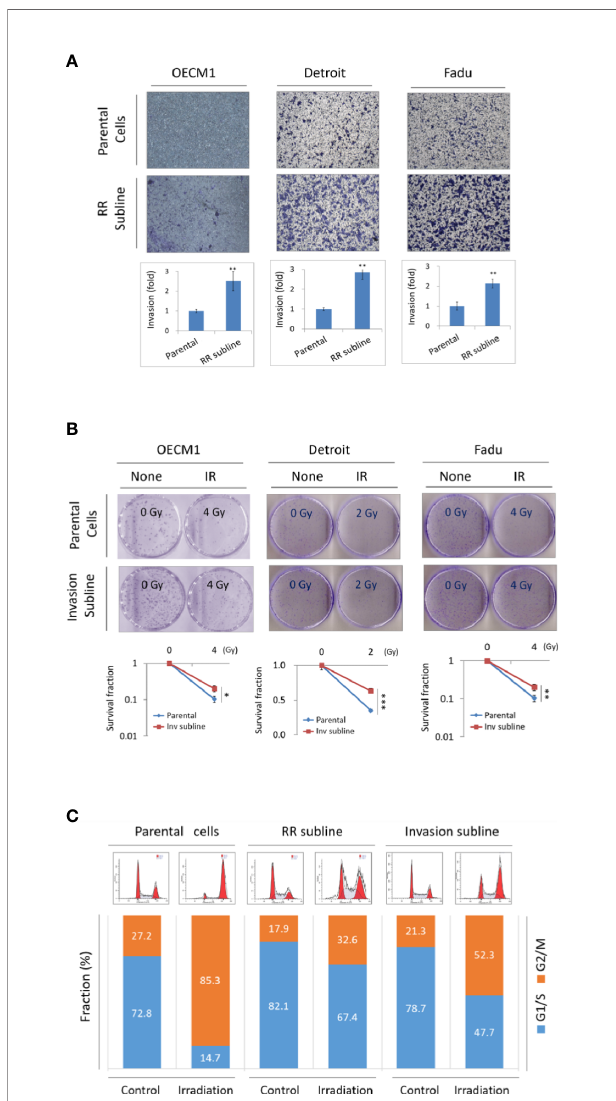
FIGURE 1 | Phenotypic cross-talk between cell invasion and radioresistance in HNC. (A) Radioresistant sublines exhibited higher cell invasion ability compared to the parental cells, as determined by Matrigel invasion assay. Total of 3 HNC parental cell lines (OECM1, Detroit, and Fadu) and their radioresistance sublines (RR sublines) were examined. The numbers of cells that had invaded through the Matrigel to the reverse side were stained, photographed and quanti fi ed. (B) The invasion sublines showed statistically more resistant to irradiation compared to their parental cells, as determined by clonogenic survival assay. Total of 3 HNC parental cell lines (OECM1, Detroit, and Fadu) and their invasion sublines were examined. The colony survival fractions were determined after the cells were irradiated with 2 or 4 Gy. The experiments were performed for three times, and the similar results were obtained. The error bars shown in the relevant fi gures indicated the standard deviation of the three independent experiments. (*p < 0.05, **p < 0.01, ***p < 0.001, t-test). (C) Both Invasion and radioresistant sublines enrich cells at G1/S phase in response to irradiation. The OECM1 parental cell, the RR subline or the invasion subline were examined. Cells were then synchronized to the G0 phase by replacing the culture medium with serum- free medium. The cells were treated with a single dose of 6 Gy of irradiation and continuously cultured for 24 hours. In each sample, cell cycle distribution was determined by fl ow cytometry